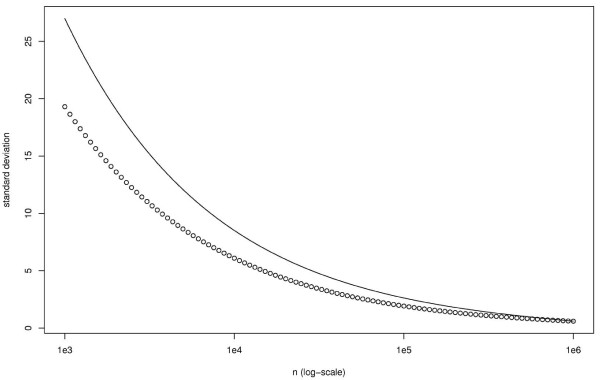
Comparison of σ(n) and σ˜
 MathType@MTEF@5@5@+=feaafiart1ev1aaatCvAUfKttLearuWrP9MDH5MBPbIqV92AaeXatLxBI9gBaebbnrfifHhDYfgasaacH8akY=wiFfYdH8Gipec8Eeeu0xXdbba9frFj0=OqFfea0dXdd9vqai=hGuQ8kuc9pgc9s8qqaq=dirpe0xb9q8qiLsFr0=vr0=vr0dc8meaabaqaciaacaGaaeqabaqabeGadaaakeaaiiGacuWFdpWCgaacaaaa@2E85@(n). The circles reprensent σ(n) and the solid line σ˜
 MathType@MTEF@5@5@+=feaafiart1ev1aaatCvAUfKttLearuWrP9MDH5MBPbIqV92AaeXatLxBI9gBaebbnrfifHhDYfgasaacH8akY=wiFfYdH8Gipec8Eeeu0xXdbba9frFj0=OqFfea0dXdd9vqai=hGuQ8kuc9pgc9s8qqaq=dirpe0xb9q8qiLsFr0=vr0=vr0dc8meaabaqaciaacaGaaeqabaqabeGadaaakeaaiiGacuWFdpWCgaacaaaa@2E85@(n). n∞ = 106 have been used to compute the value of A and B. Nobs = 1221 and ℓ = 10 000.